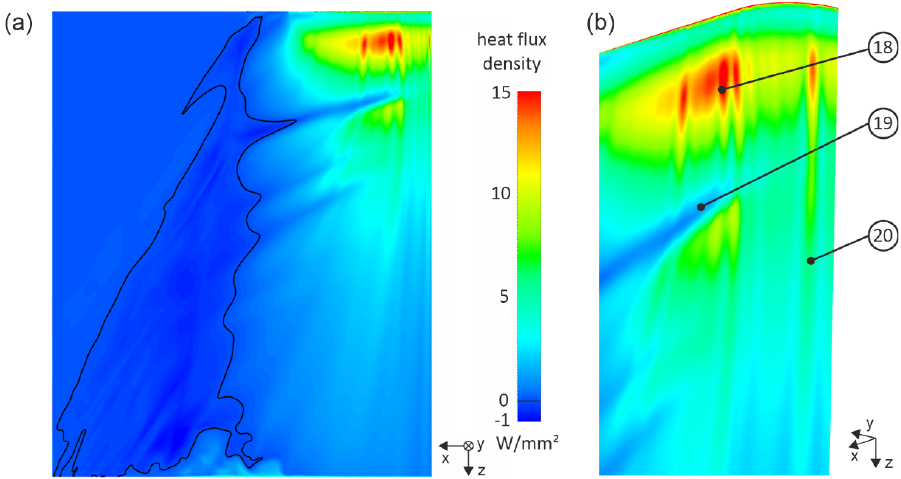
Figure 6. Local heat flux density, zero line marked as shift from cooling the wall by gas flow to heating; ( a ) overall view of front and cut edge; ( b ) perspective view of top front and edge. Additionally, local boundary layer thickness and pressure influenced the heat trans- fer. The highest heat flux densities of about 15 W/mm 2 were achieved in the area of the reattachment line of the inflow separation, since the highest pressure and the thinnest boundary layer are reached here (18). Because of the global decrease in pressure and in- crease in the boundary layer thickness in flow direction, the heat transfer decreased con- sistently with the shear stresses in the direction of the kerf outlet.